Question: Author a descriptive caption for the visualization shown.
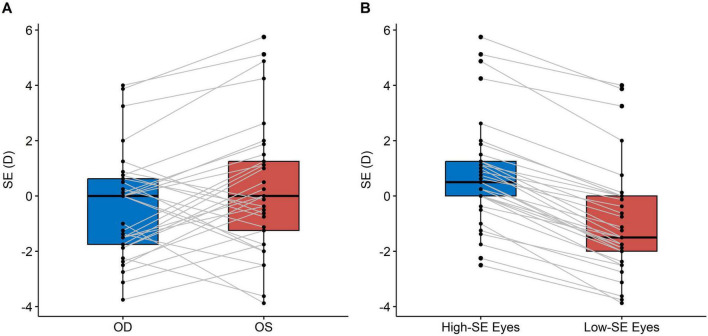
Answer: Distribution of spherical equivalent (SE) in patients with myopic anisometropia ( n = 33). (A) Between right and left eyes. (B) Between low-SE eye and high-SE eye. D, Diopter; OD, right eyes; OS, left eyes.